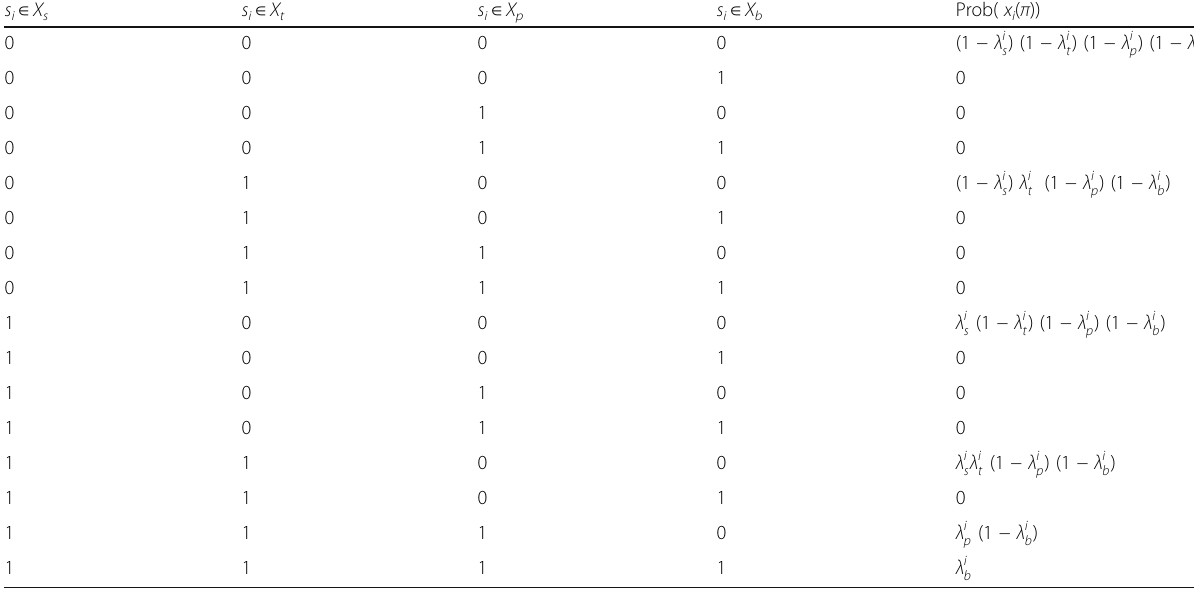
; λ i ; λ i , λ i are the probabilities of failure of the four main components s t p b